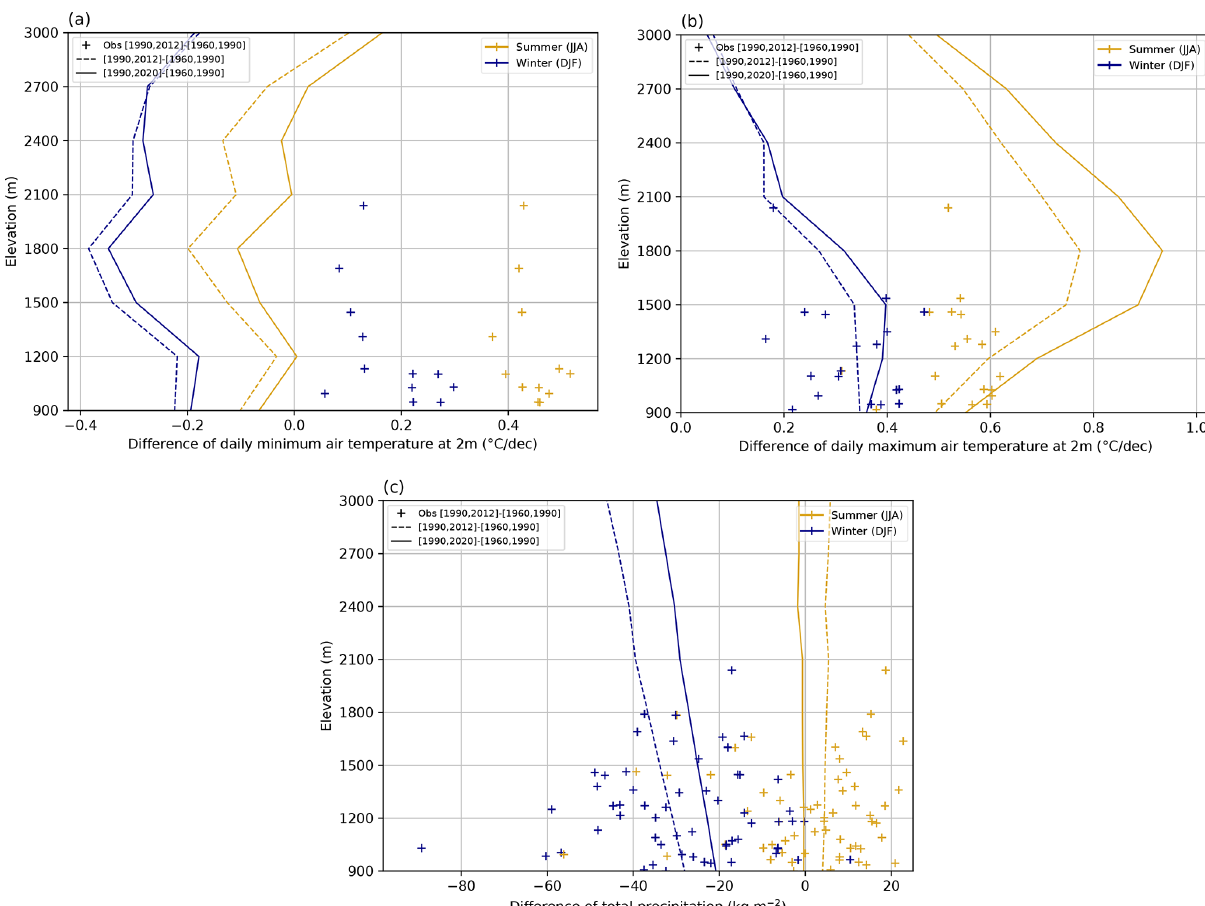
Figure 12. Difference of the mean simulated daily minimum (a) and maximum (b) 2m air temperature and total precipitation (c) for different elevations in summer and winter between the climatological periods 1990–2020 and 1960–1990 (solid line) and 1990–2012 and 1960–1990 (dotted line) over the Alps. Crosses represent the corresponding observed difference on a set of homogenized observation series between the periods 1960–1990 and